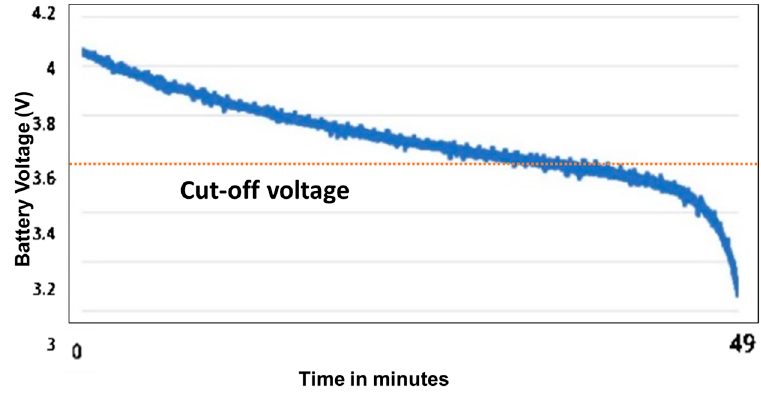
Figure 11. Battery discharge curve of iTex glove during continuous wireless transmission (Battery cut-off voltage set to 3.7 V in AXP192).